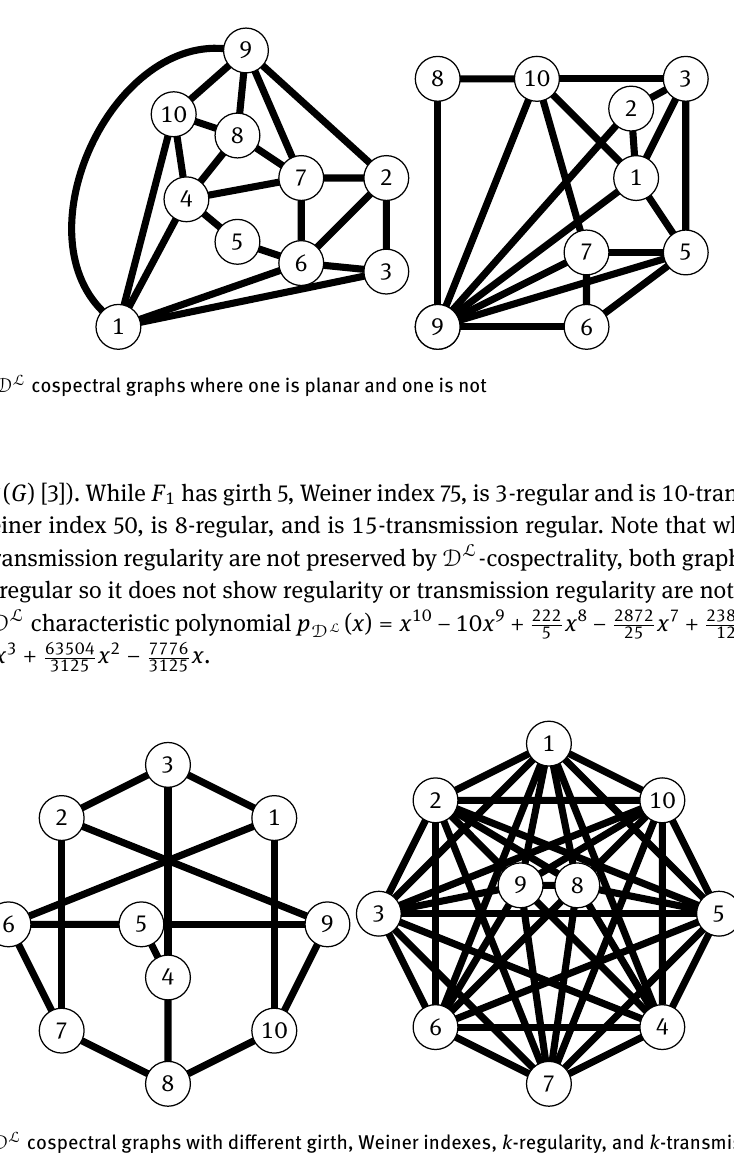
Figure 6: G 1 and G 2 , D L -cospectral pair on 9 vertices with a different number of edges, different degree sequences, and differ- ent transmission sequences